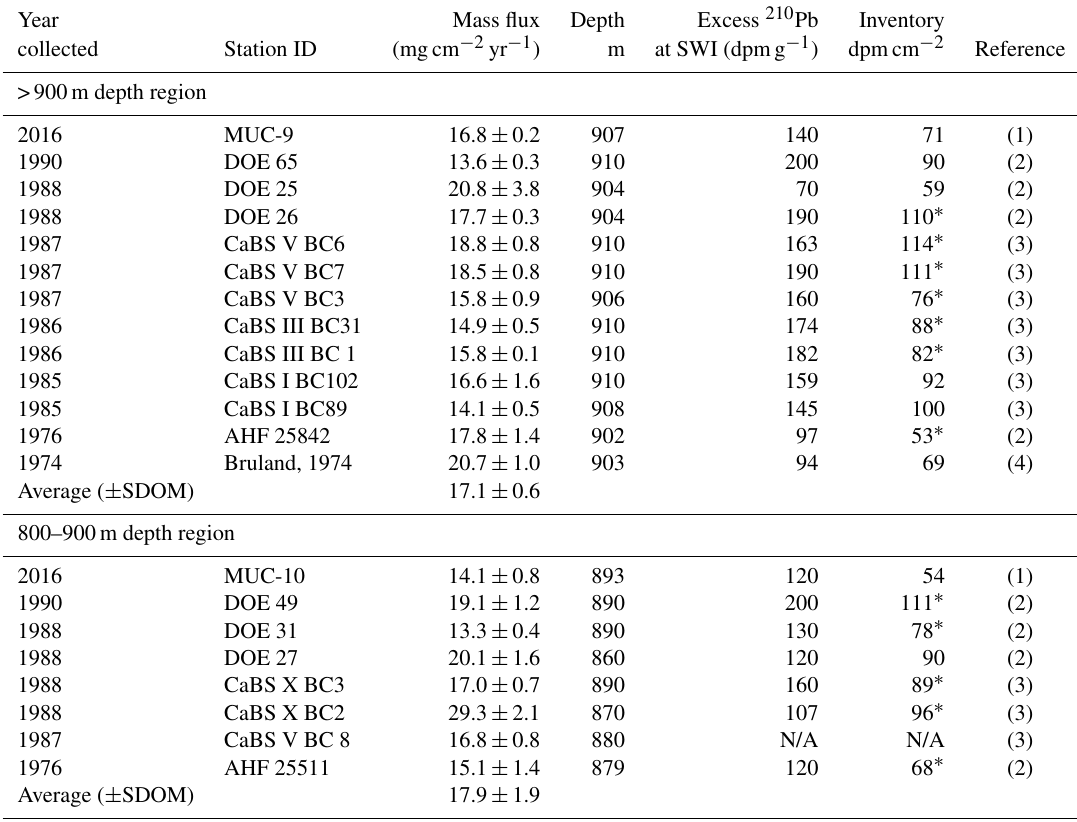
Table 2. Station ID, year collected, mass flux, depth, inventory and excess 210 Pb at the sediment–water interface (SWI) for all cores greater than 800m depth in the Santa Monica Basin. The first 13 cores are from deeper than 900m, and the last 8 cores are from 800 to 900m water depth. The 210 Pb inventory was also computed, but values are not discussed in this article (references: (1) this work; (2) Christensen et al., 1991; (3) Huh et al., 1989; (4) Bruland,